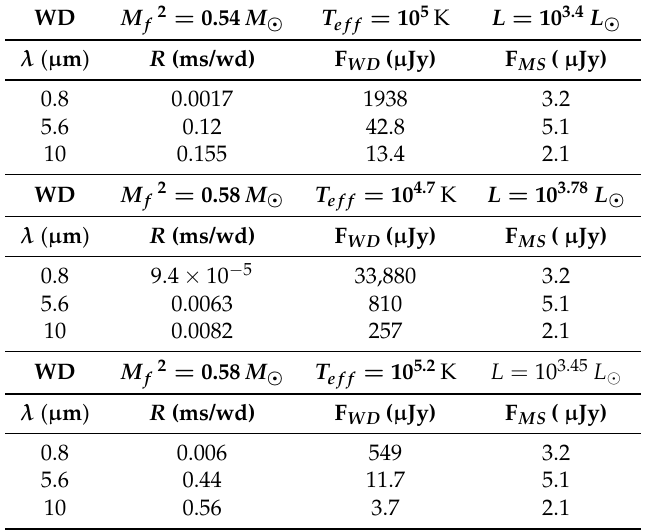
Table 1. Mid-infrared (IR) excess of a main-sequence (MS) companion 1 in a central star of PNe (CSPN). WD M f 2 = 0.54 M